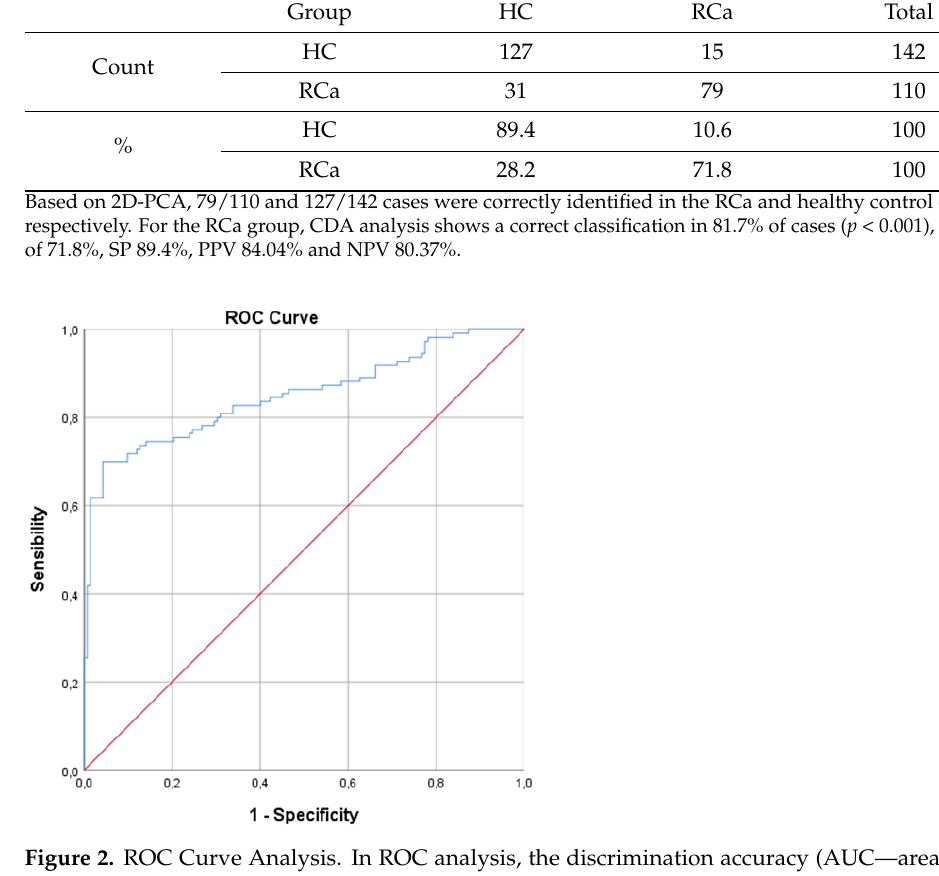
Figure 2. ROC Curve Analysis. In ROC analysis, the discrimination accuracy (AUC—area under the curve) between renal patients and healthy controls was 0.85. Repeated analyses with a second measure obtained from the same urine samples set provided comparable findings (CVA 81.3%, AUC 0.9, sensitivity 71.8% and specificity 88.7%).